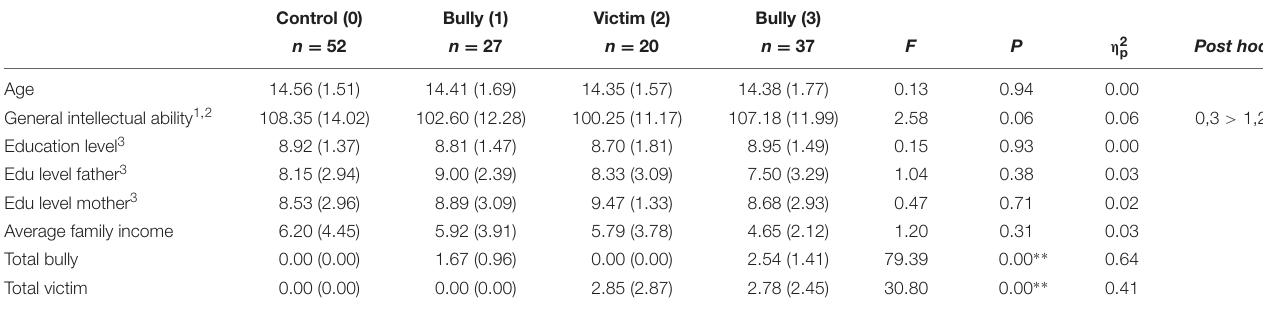
TABLE 1 | Characteristics of controls, bullies, victims, and bully victims.